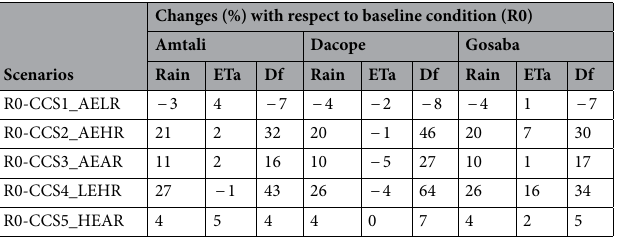
Table 3. Impact of projected future climate on rainfall (Rain), actual evapotranspiration (ETa) and surface runoff (Df).